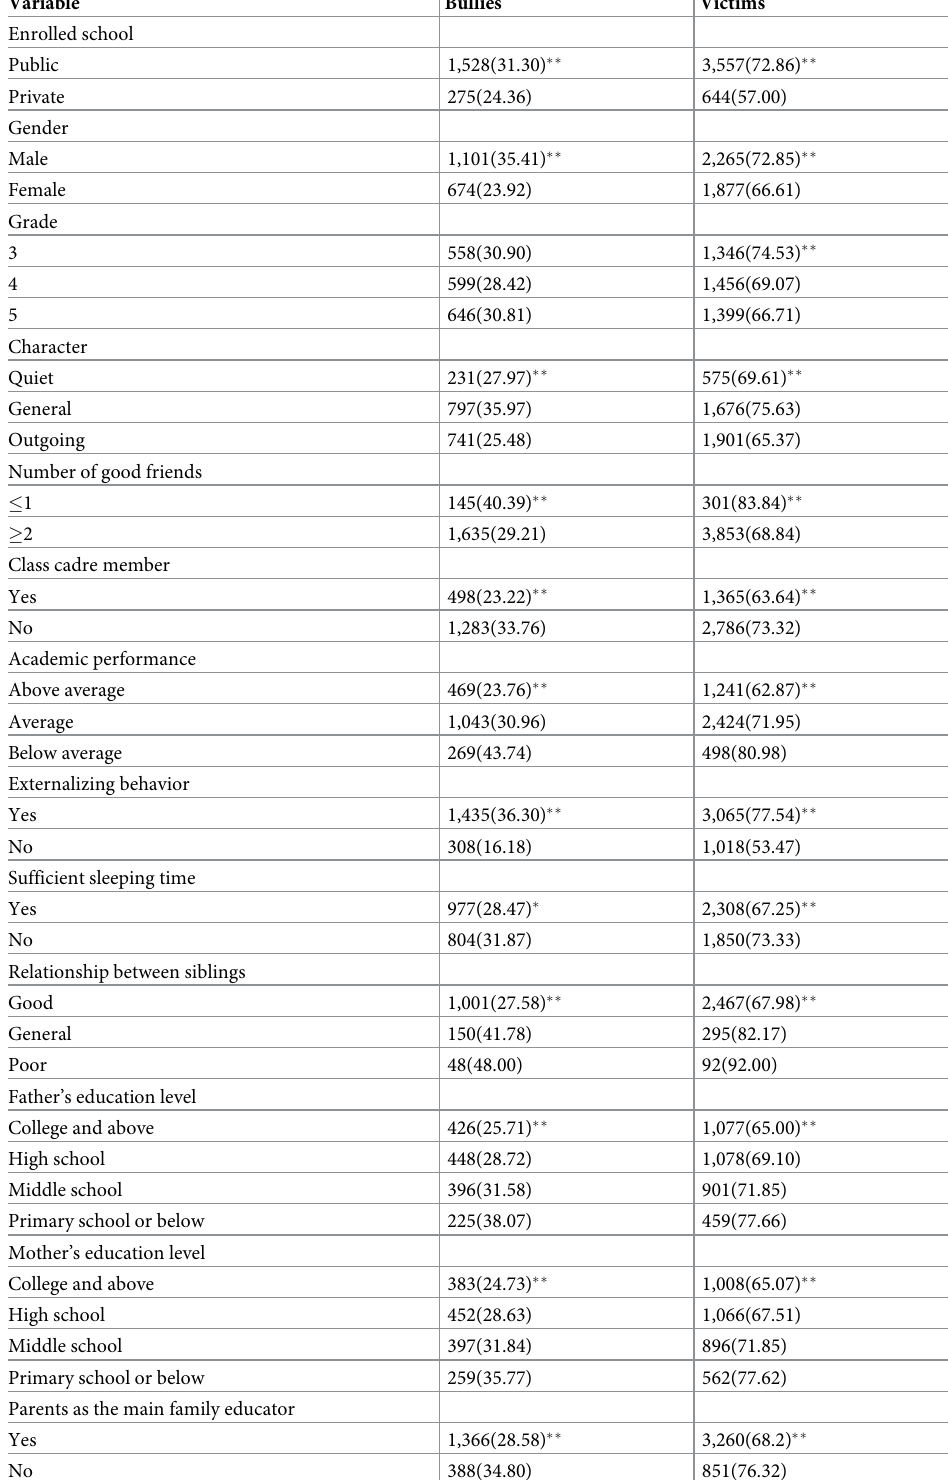
Table 3. Characteristics and frequency distribution for bullies and victims (n